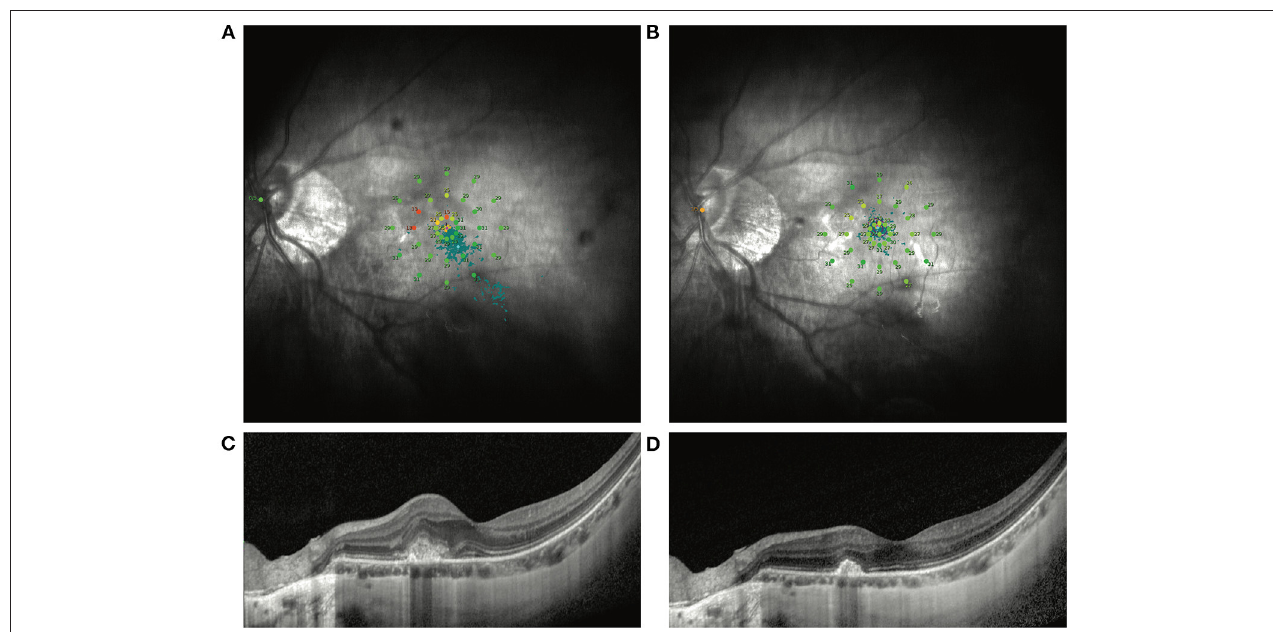
FIGURE 1 | Representative MP1 findings in an mCNV patient without VA improvement after ranibizumab treatment. (A) Shows the image of the MP1 before ranibizumab treatment in an mCNV patient with baseline BCVA as 67 ETDRS letters. After treatment, the VA increased by only 1 ETDRS letter. Nevertheless, the macular sensitivity and fixation improved dramatically by MP1 (B) . OCT images also show the remission of the CNV lesion in the macular (C,D) .